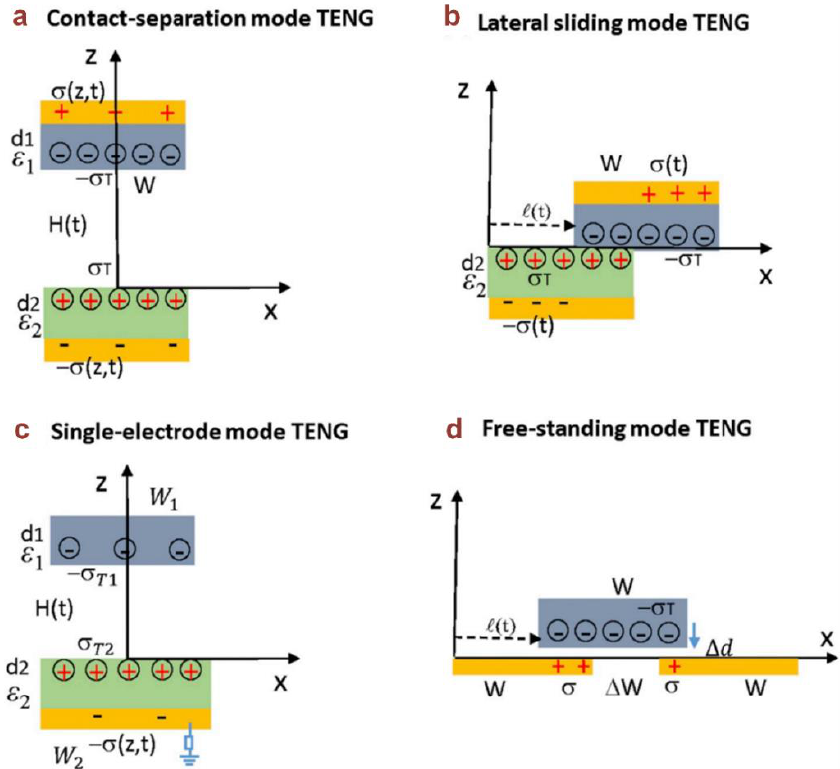
Figure 4. Coordination system and mathematical parameters defined for describing ( a ) contact-separation, ( b ) lateral sliding mode, ( c ) single-electrode mode, and ( d ) free-standing mode triboelectric nanogenerators (TENGs), respectively. Reproduced with permission [21]. Copyright 2020, Elsevier.